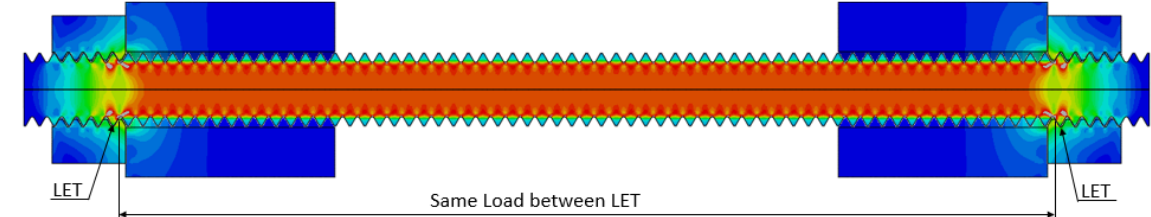
Figure 11. Detail of FEA for studs showing the same tensile load between the last engaged threads (LET). Figure 12 shows the strain (mm/mm) for studs with nut interface at the situations where the maximum nominal stress values at the studs were 50%, 70%, and 90% of the of the yield, a small region at the bottom of the thread reached plasticity, due to the stress concentration. The regions with higher strain values, pointed by arrows, correspond to reducing the fatigue crack nucleation period. The plastic deformation accumulation increased with the increase of the applied stress, which is also related to a detrimental